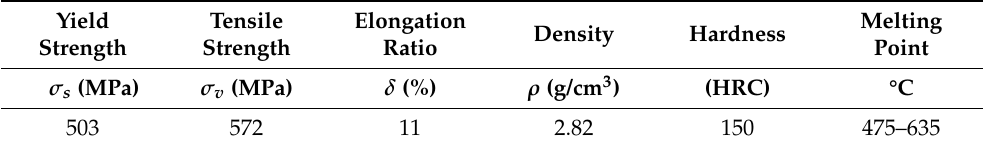
Table 3. Properties of 7075 aluminum alloy at normal temperature.